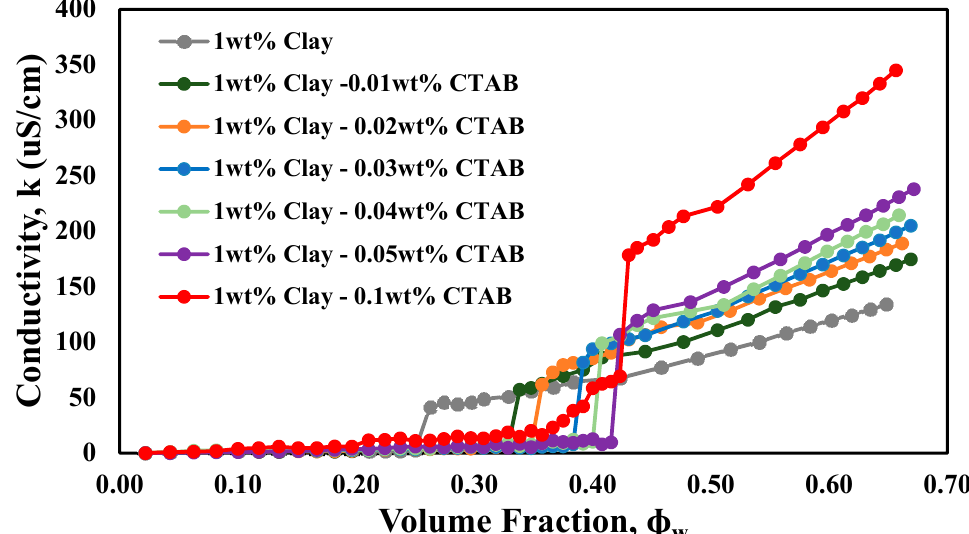
Figure 14. Conductivity of water–mineral oil emulsions stabilized by 1 wt% nanoclay at varying CTAB concentrations as a function of the volume fraction of water.